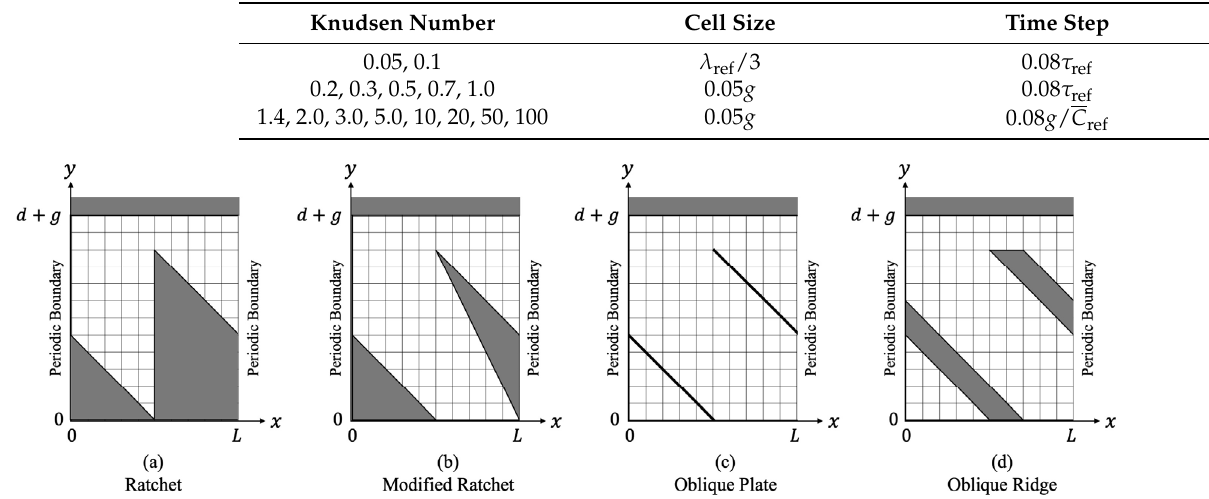
Figure 2. Computational domain used in each microstructure.